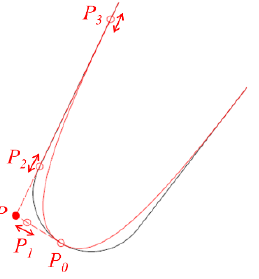
Figure 3. Leading-edge geometry